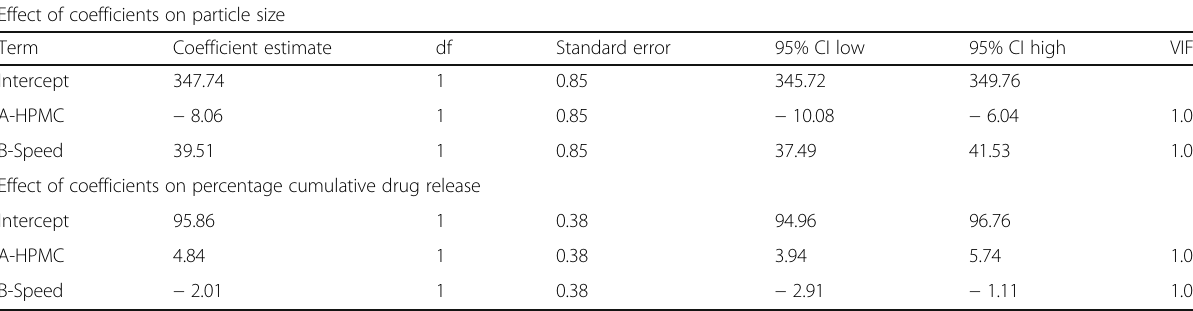
Table 7 Effect of formulation development